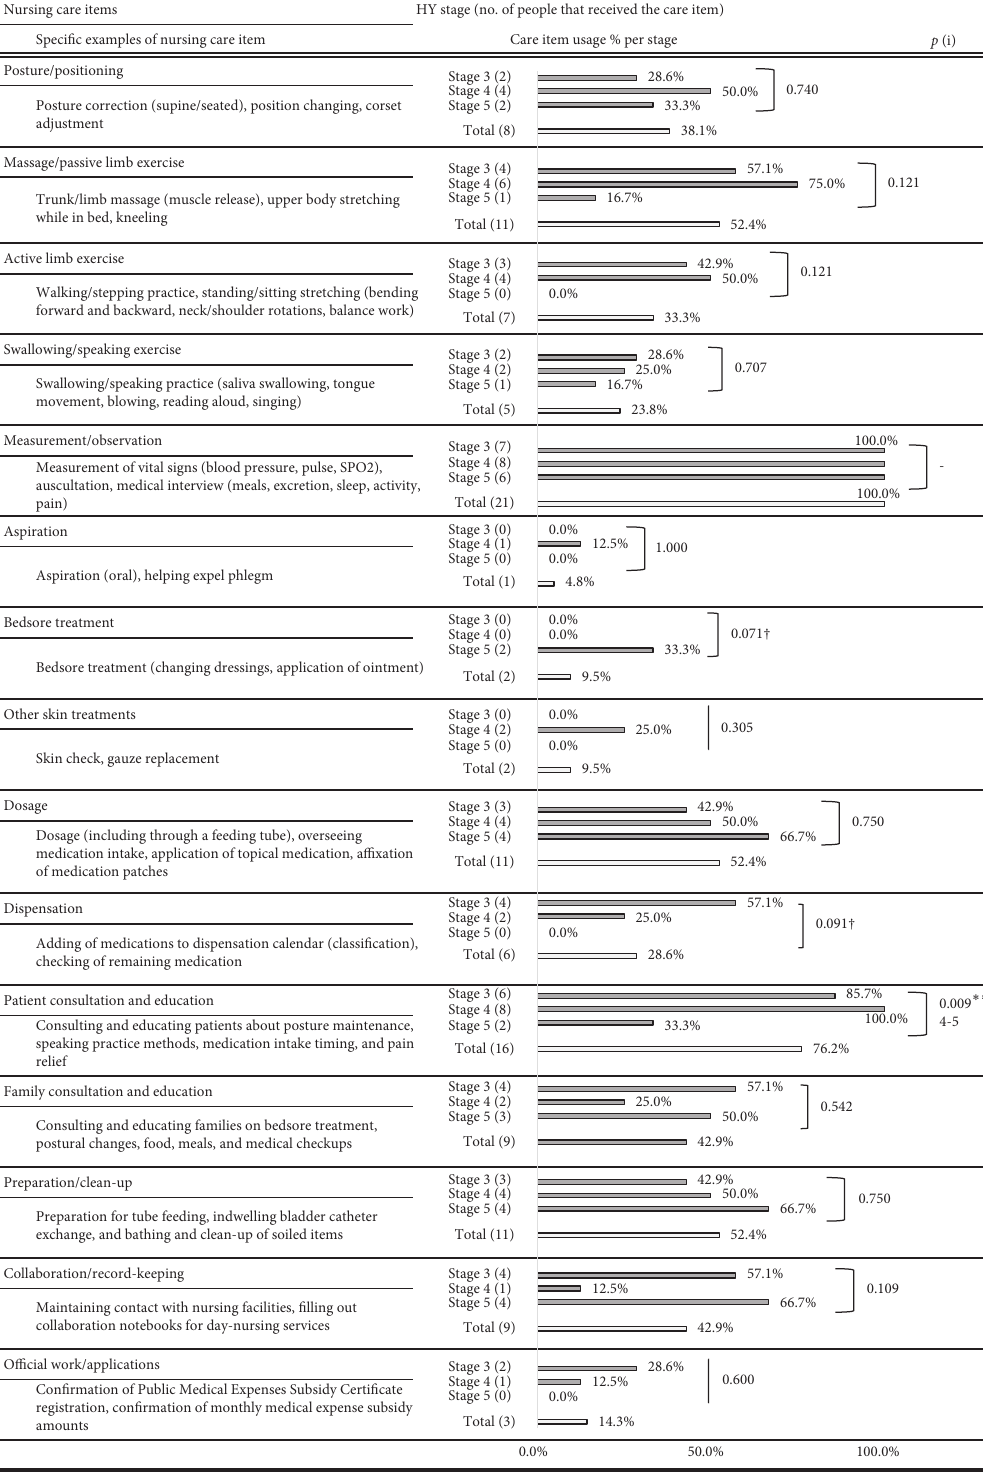
Figure 2: Comparisons of the percentage of nursing care provided at each HY stage. (i) Fisher’s exact test (every side) indicates significantly different pairs ( p < 0 . 05) after Bonferroni correction; † p < 0 . 1, ∗ p < 0 . 05, and ∗∗ p < 0 . 01; p values and percentages have been rounded